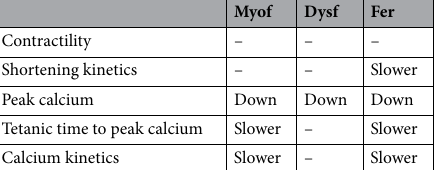
Table 1. Summary of physiological changes compared to